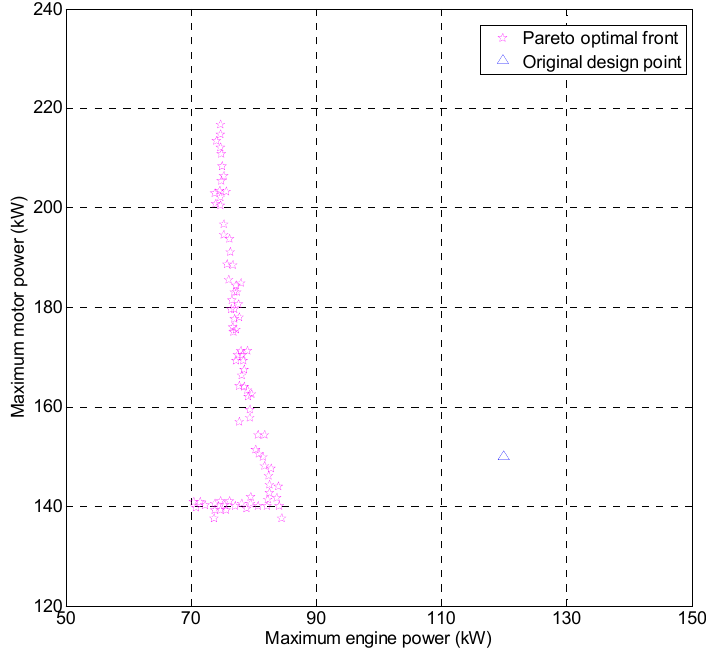
Figure 11. Fitting curve of the Pareto frontier.